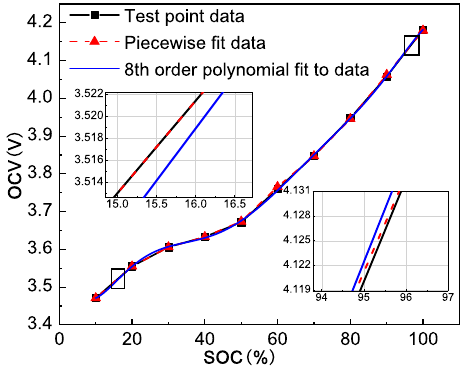
Figure 3. OCV-SOC fitting